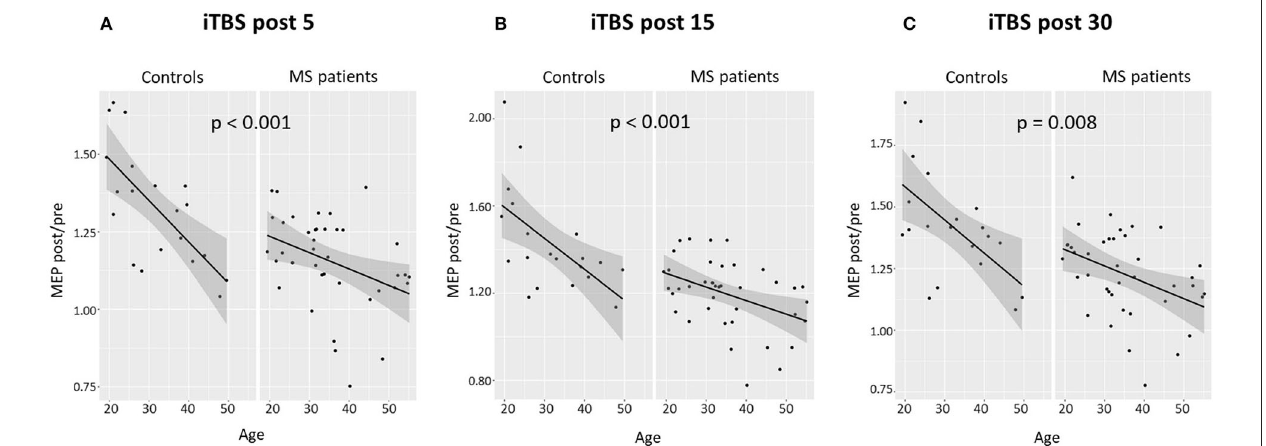
FIGURE 4 | Age and LTP-like synaptic plasticity in patients with MS and control subjects. Correlation between age and iTBS-induced effects in patients with MS and controls at different time points: (A) 5min, (B) 15min, and (C) 30min. The data are expressed as mean MEP amplitudes (MEP post) normalized to the mean